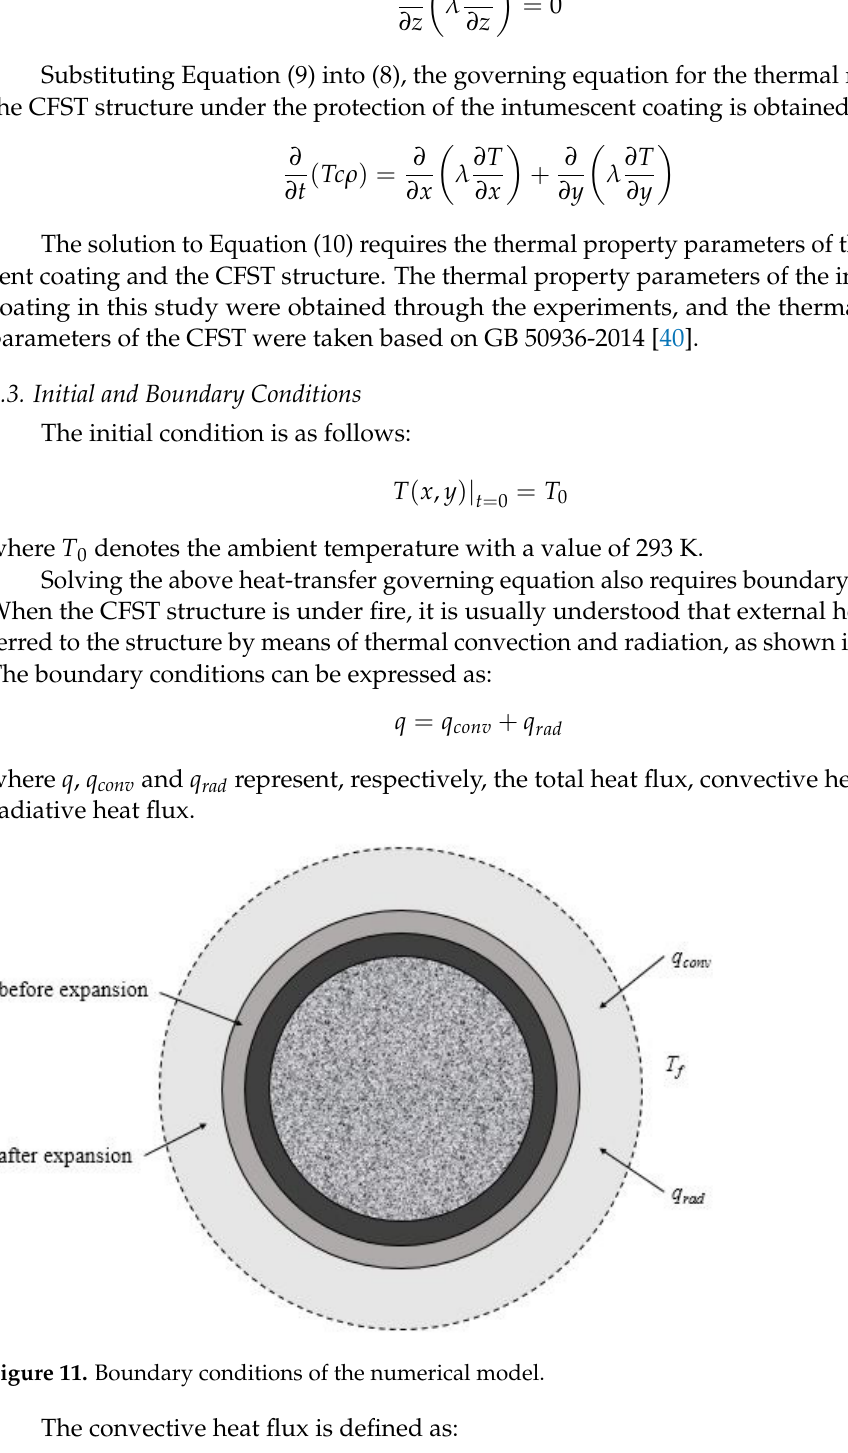
Figure 11. Boundary conditions of the numerical